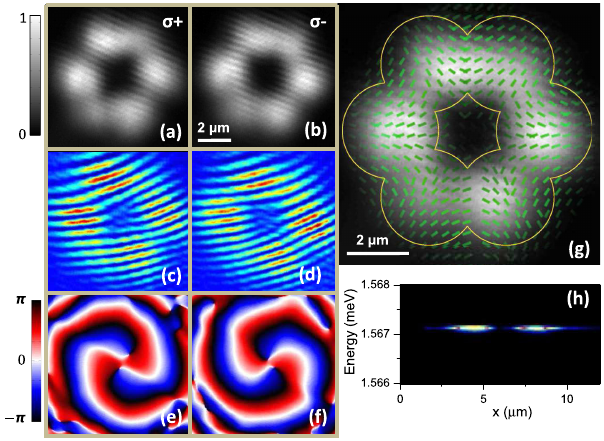
FIG. 5. Condensation in the k ¼ 3 state of the E ð 2 Þ manifold. (a,b) Real space emission in the σ and σ − circular polarizations þ k ¼ 3 Þi , at 25 mW. for a polariton condensate in the state j ψ lower ð Each polarization component contains a vortical current of double phase charge in the counterclockwise ( σ ) and clockwise þ ( σ − ) directions, evidenced in the double forklike dislocations apparent in the interferometric measurements shown in (c) and (d), respectively, and in the extracted phase gradients in (e) and (f). The phase changes from 0 to (cid:2) 4 π when circumventing the molecule. (g) The green traces show the plane of linear polari- zation of the emission measured locally, superimposed to the total emitted intensity of the molecule. At the center of each micro- pillar, the condensate shows a linear polarization pattern pointing radially. Solid lines depict the contour of the microstructure. (h) Spatially resolved emission